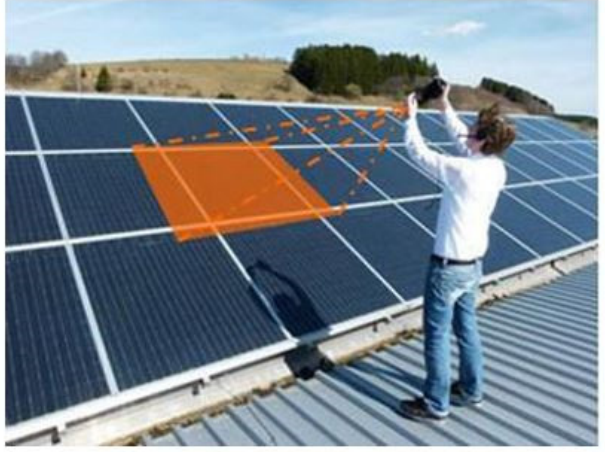
Figure 13. A manually captured thermographic image of small-scale PV modules [55].